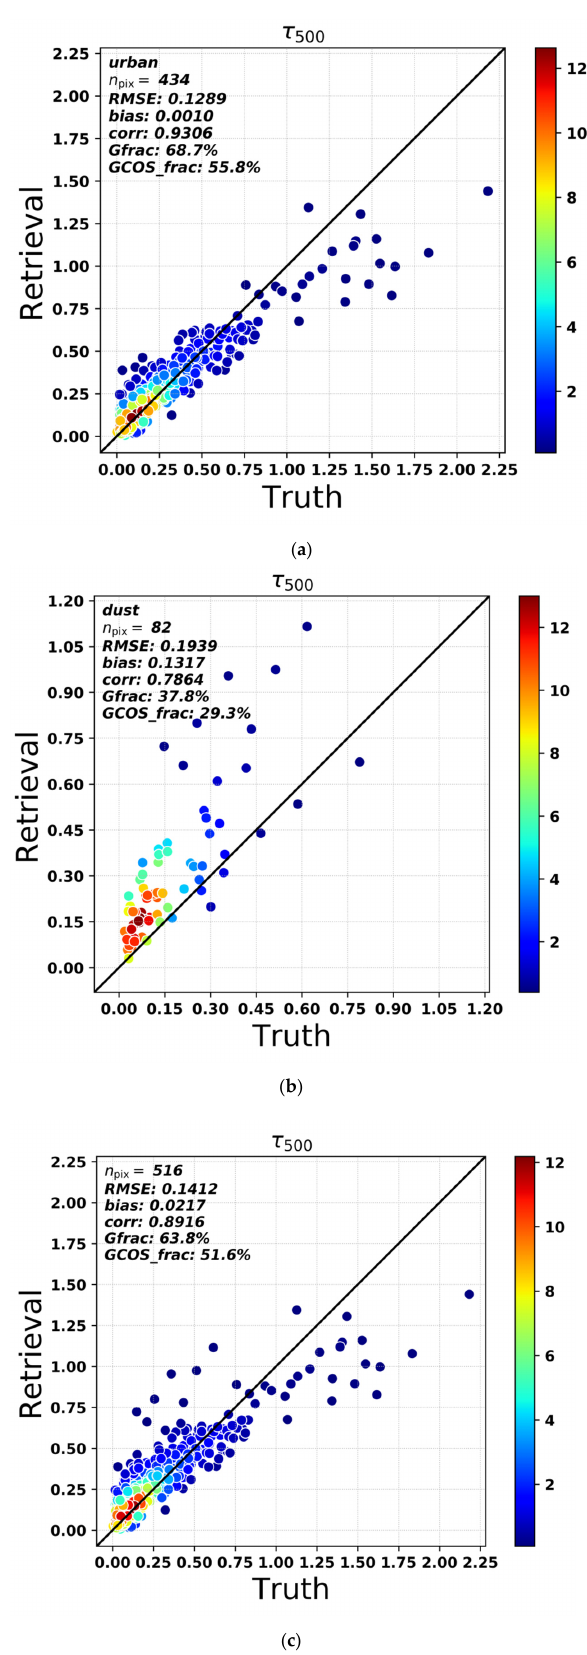
Figure 4. Same as Figure 1 but for the fine mode AOD. The validation results for urban stations (FMF ≥ 0.5), dust stations (FMF < 0.5) and all matchups are shown in subplot ( a – c ), respectively. Compared with the total AOD validation as shown in Figure 1c, the Gfrac of fine mode AOD retrievals is significantly improved (63.8% and 47.3% for fine and total AOD, respectively), which further indicates that DPC retrievals have better capability for scenes dominated by fine particles. Wu et al., 2015 concluded that the inclusion of